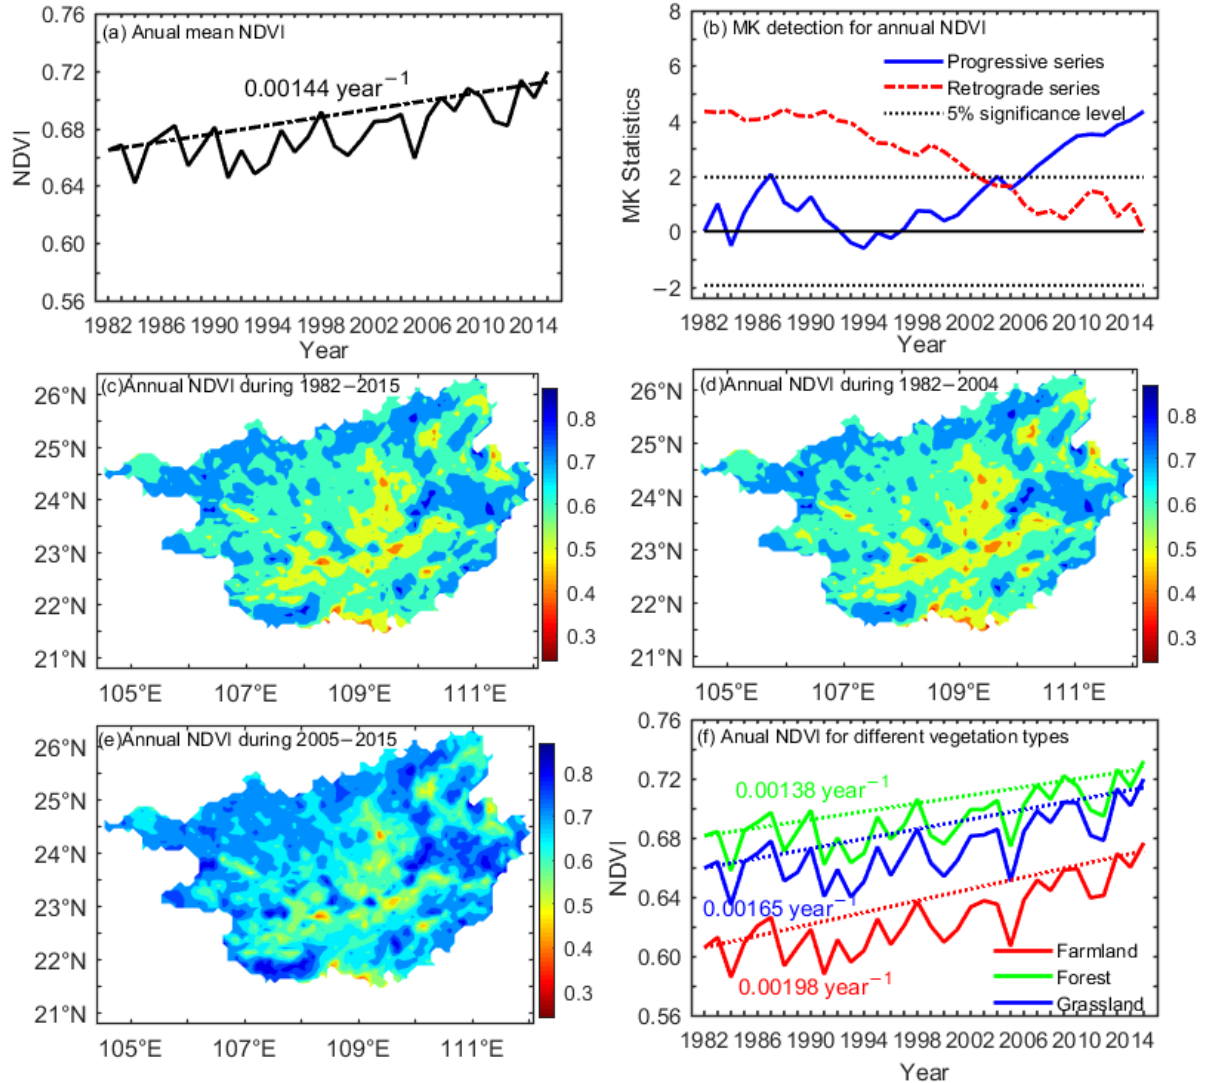
Figure 3. Annual mean NDVI in Guangxi during 1982–2015 ( a ); the Mann–Kendall (MK) abrupt change detection for the annual NDVI during 1982–2015 ( b ); spatial distributions of the annual NDVI during 1982–2015, 1982–2004, and 2005–2015 ( c – e ); and annual mean NDVI for different vegetation types during 1982–2015 ( f ). Note: in ( a , f ), the solid line represents the observed NDVI, and the dotted line represents the fitted NDVI.